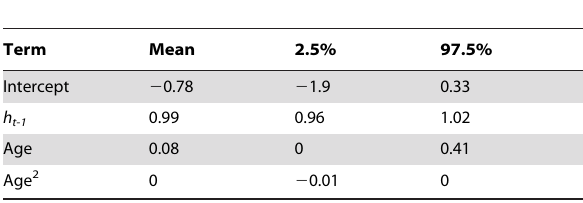
Table 1. Estimates of the beta parameters in the regression for health, h t . Health at the previous time-step has a strong relationship to health at current